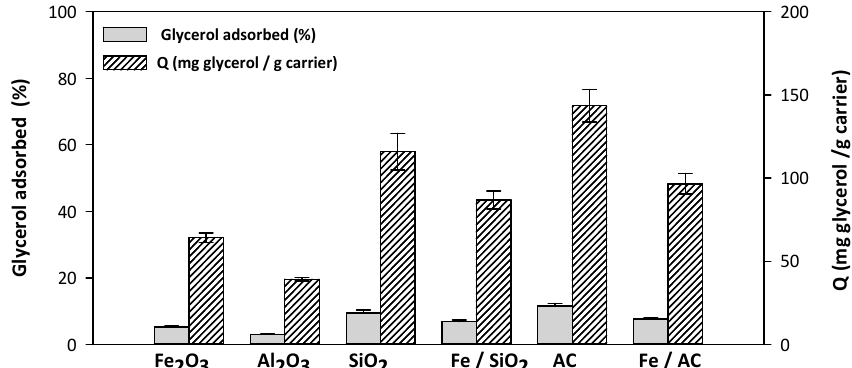
Figure 7. Effect of support on glycerol adsorption.